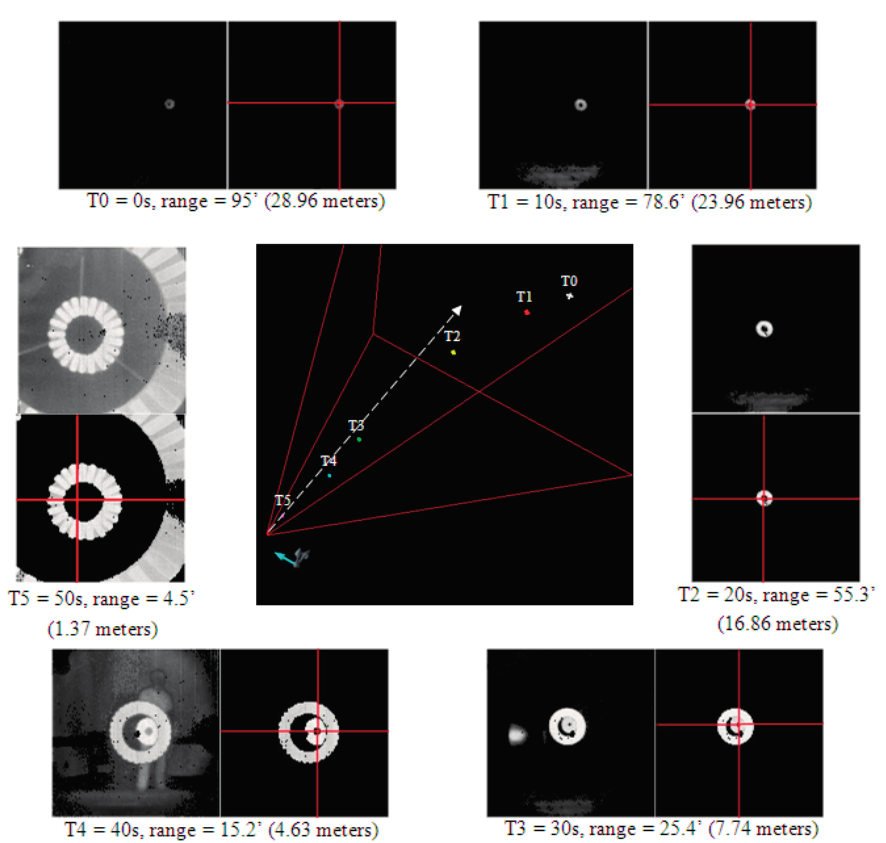
Figure 17. Experimental results from a successful catch